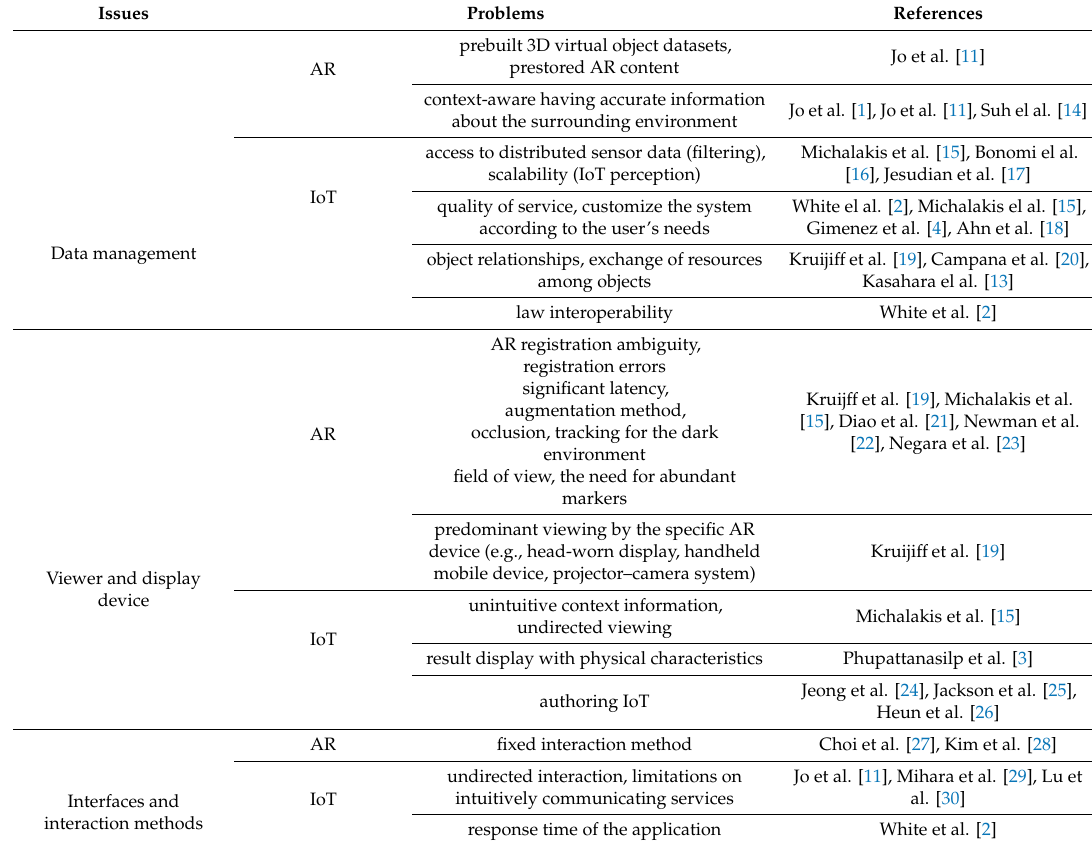
Table 1. Classification of Issues and Problems in AR and